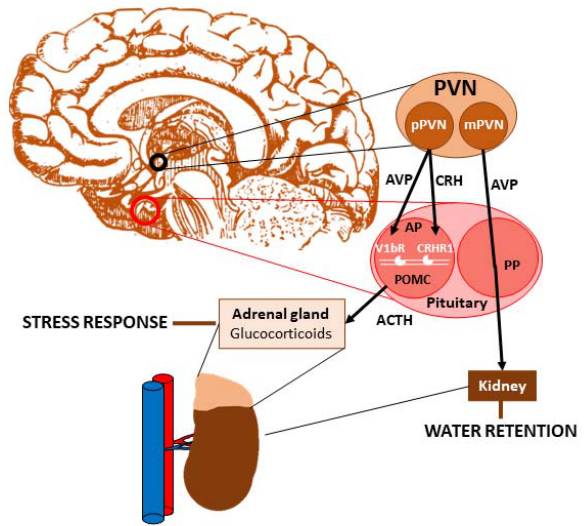
Figure 1. Role of vasopressin (AVP) in stress axis regulation. AVP produced in the magnocellular region of the paraventricular nucleus (PVN) is transported through the posterior pituitary to the blood stream and is responsible for water reabsorption in the kidney. AVP and corticotropin-releasing hormone (CRH) produced in the parvocellular population of PVN are released to the portal circulation of the pituitary, reaching the anterior lobe where they stimulate proopiomelanocortin-producing cells via acting on V1bR and CRHR1 receptors, thereby promoting adrenocorticotropic hormone (ACTH) synthesis and release. In the adrenal cortex, ACTH induces glucocorticoid production (e.g., cortisol), which triggers a response to stress. Abbreviations: ACTH: adrenocorticotropic hormone; AP: anterior pituitary; AVP: vasopressin; CRH: corticotropin-releasing hormone; CRHR1: CRH receptor type 1; mPVN: magnocellular cell population of paraventricular nucleus; POMC: proopiomelanocortin; PP: posterior pituitary; pPVN: parvocellular cell population of paraventricular nucleus; PVN: paraventricular nucleus; V1bR: vasopressin receptor type